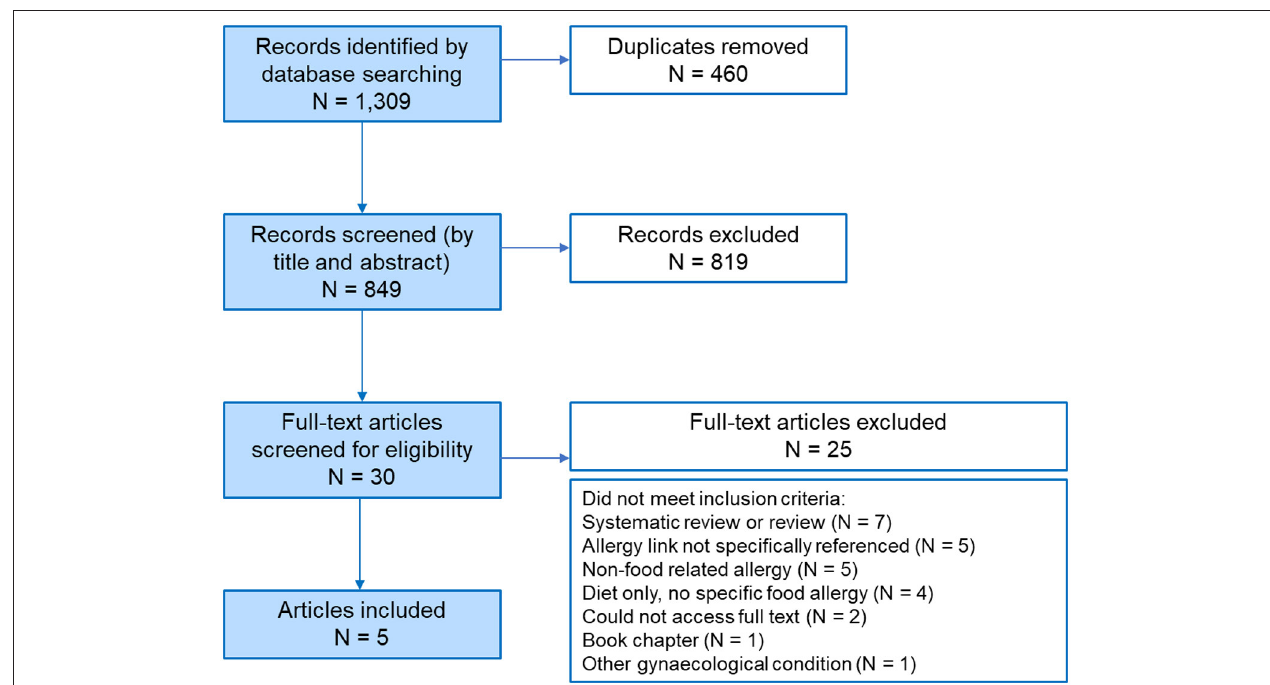
FIGURE 1 | PRISMA diagram. PRISMA flow diagram depicting the search strategy employed to compile this review. In total 1,309 records were reduced to 30 full-text articles, resulting in 5 articles that met the selection criteria outlined in the